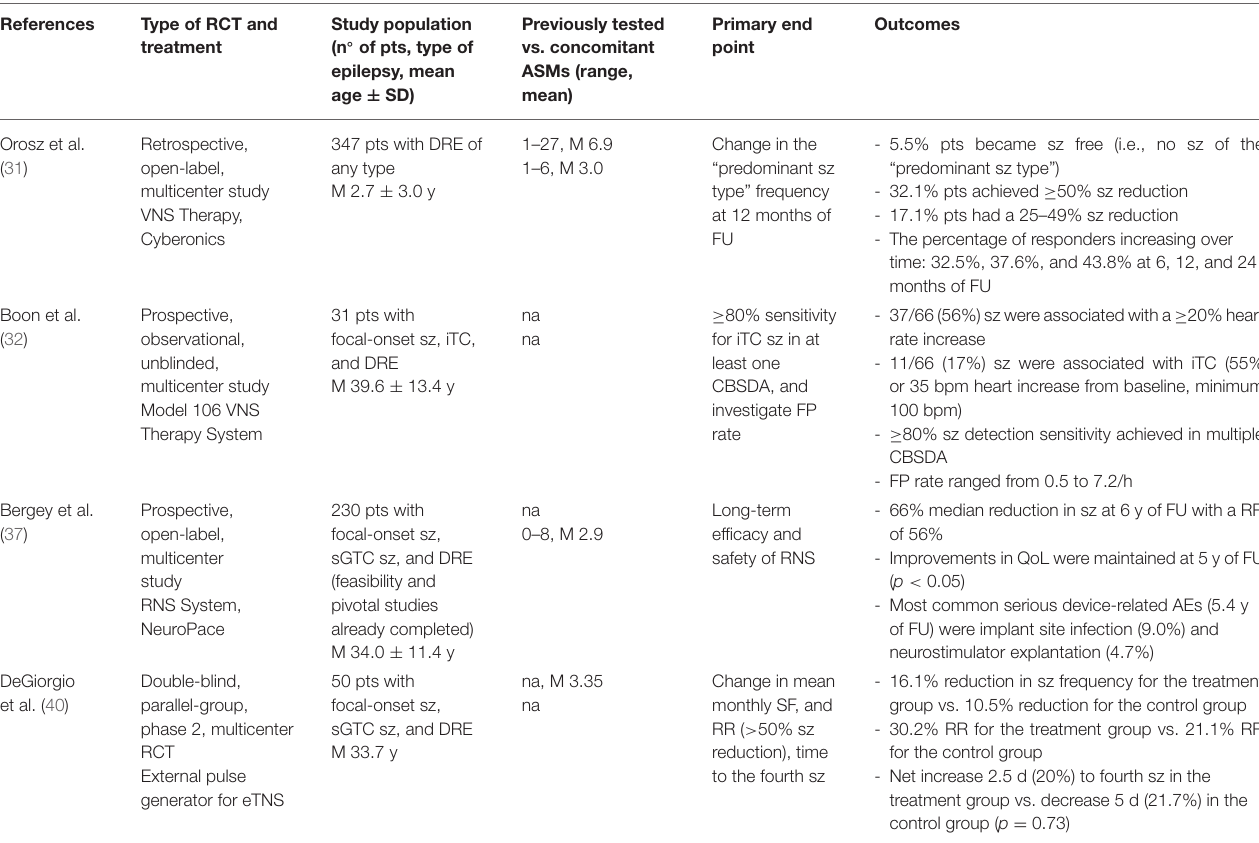
TABLE 2 | Advanced RCTs on new non-pharmacological treatments for